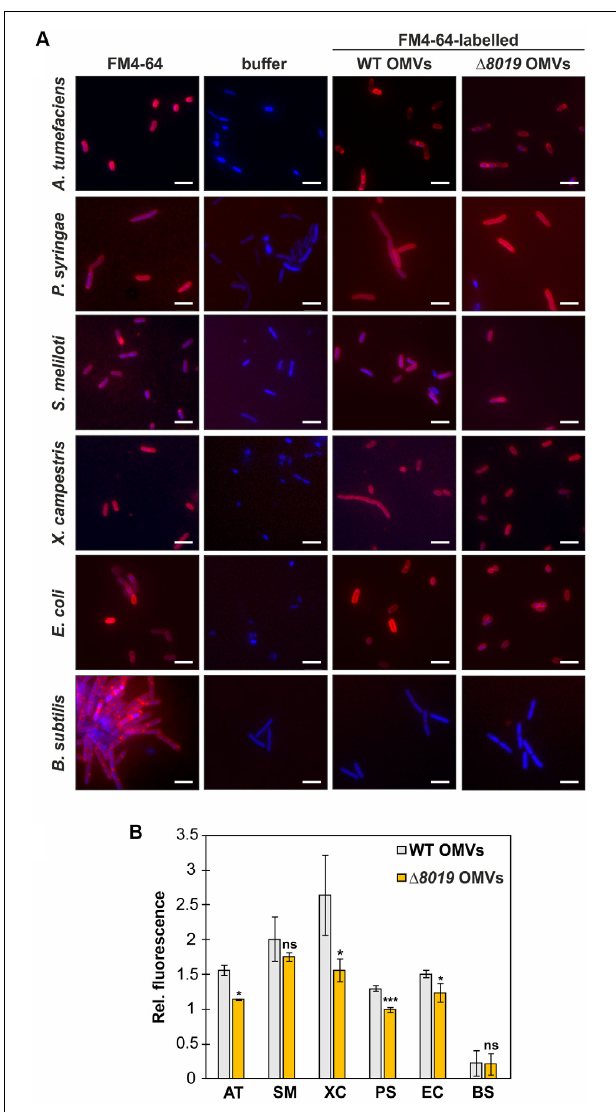
FIGURE 5 | A. tumefaciens OMVs attach to Gram-negative bacteria. (A) OMV-attachment to different bacteria visualized by fluorescence microscopy. Equal amounts of FM4-64-labeled OMVs isolated from wildtype or the atu8019 -mutant were incubated with equal amounts of Hoechst33342 (blue)-stained cells. As controls, bacteria directly stained with FM4-64, and FM4-64-free buffer controls were included. Scale bars: 5 µ m. (B) Quantification of OMV-attachment to bacteria by determination of the relative fluorescence of cells, which were incubated with equal amounts of FM4-64 labeled OMVs. Values are averages of quadruplicate assays and error bars are standard deviations. AT, Agrobacterium tumefaciens ; SM, Sinorhizobium meliloti ; XC, Xanthomonas campestris ; PS, Pseudomonas syringae ; EC, Escherichia coli ; and BS, Bacillus subtilis . The P -values noted a *are less than 0.05, **are less than 0.01, and ***are less than 0.001. Statistical testing was performed in Excel using T -test with unequal variance and two-tail hypothesis. ns, not